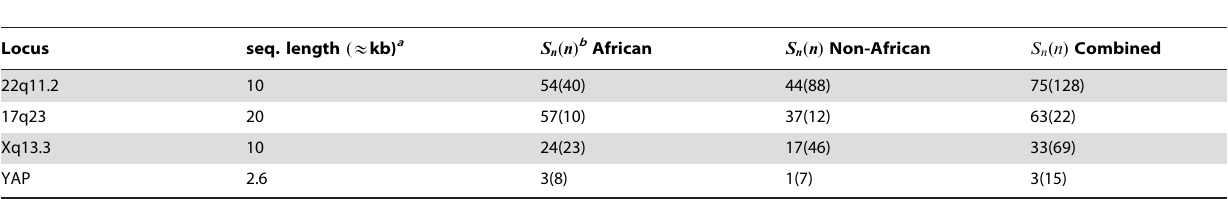
Table 1. Summary of the DNA sequence data sets from loci 22q11.2, 17q23, Xq13.3, and YAP.